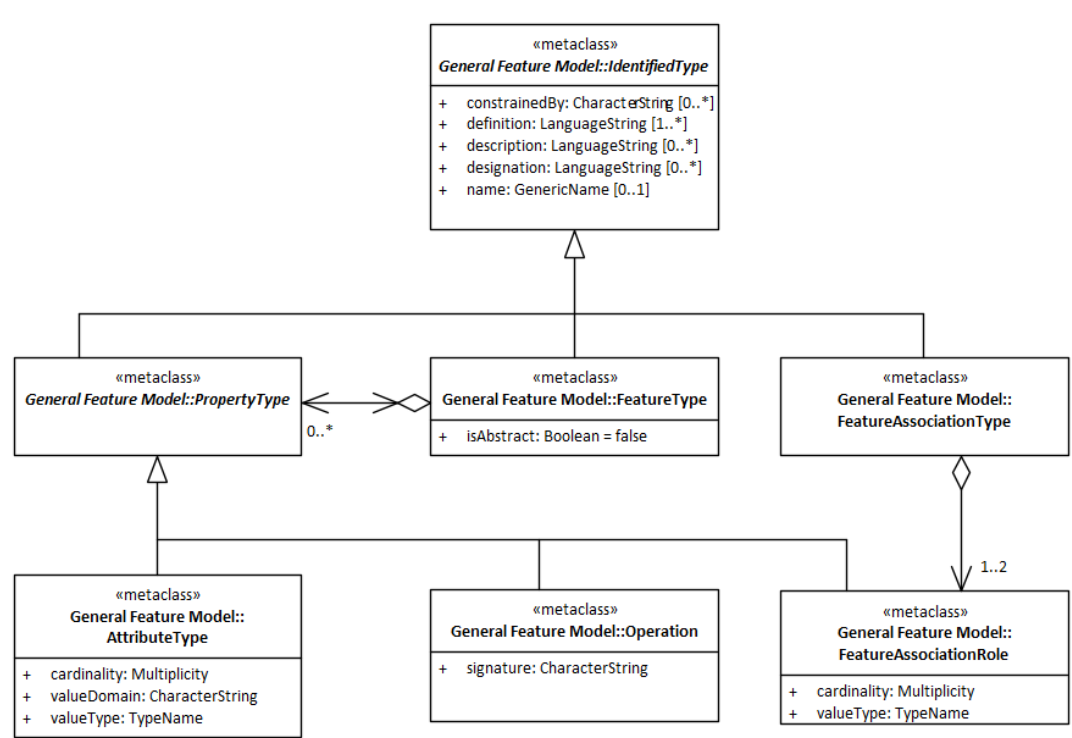
Figure 12. UML class diagram showing the ISO 19109 General Feature Model (GFM).